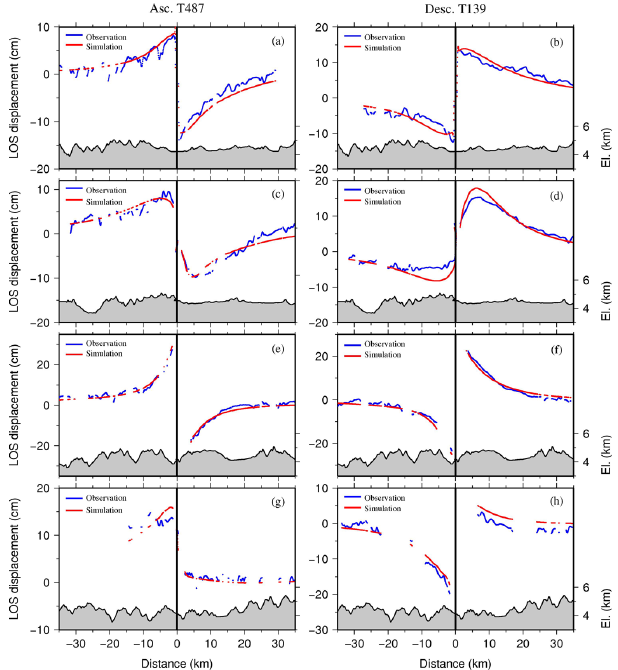
Fig. 7. Profiles of LOS displacements (blue dots), simulated LOS displacements (red dots) and topography for cross sections taken perpendicular to the four fault segments. ( a , c , e and g ) are profiles on ascending track 487. ( b , d , f , and h ) are profiles on descending track